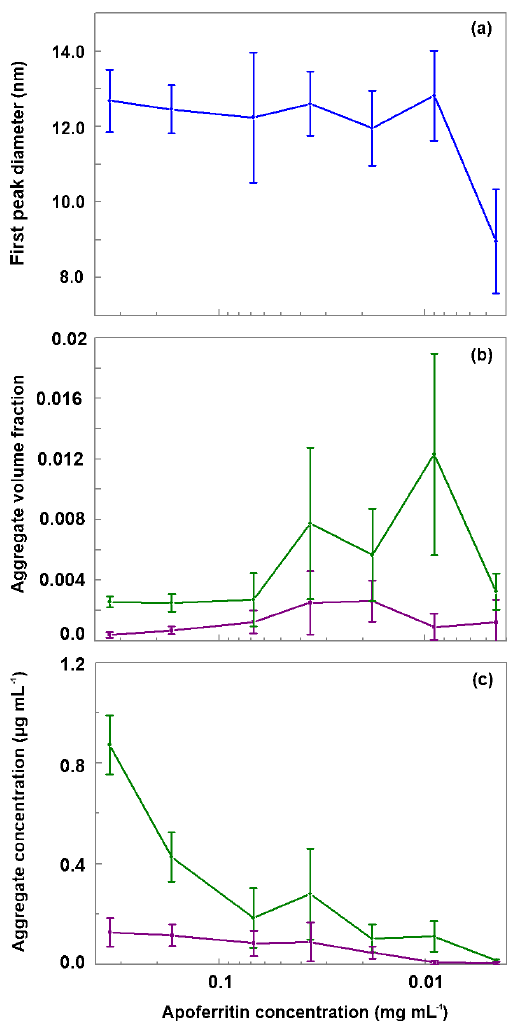
Figure 8. Evaluation of DLS measurements. (a) Hydrodynamic di- ameter of the main peak detected by DLS vs apoferritin solution concentration. (b) Relative abundance of aggregates (obtained by summing the volume-weighted distribution from 68 to 10 4 nm). (c) Absolute concentration of aggregates in the solution (obtained by multiplying the aggregate volume-weighted distribution with the apoferritin solution concentration). Green lines in panels b and c represent aggregates from 68 to 1990nm while purple lines repre- sent aggregates from 2300 to 10 4 nm. The vertical bars indicate one standard